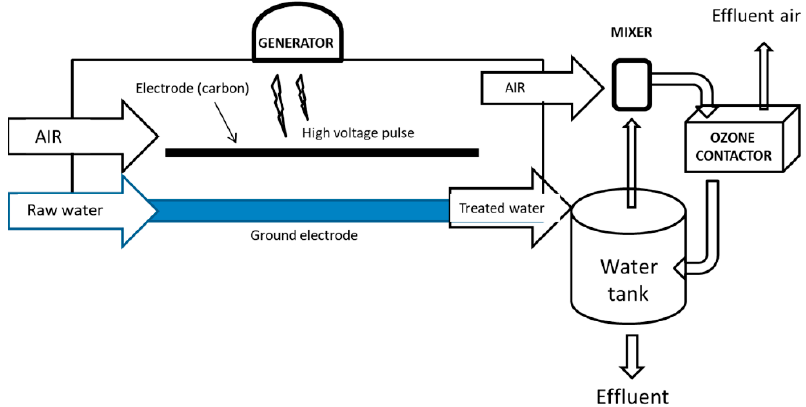
Figure 2. NTP ‘‘electrode-to-plate’’ reactor scheme described in [45]. Figure 2. NTP “electrode-to-plate” reactor scheme described in